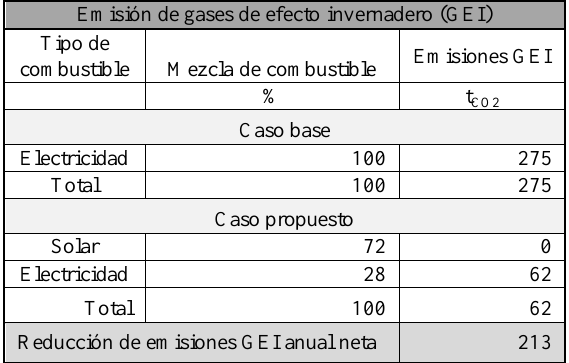
Tabla 3: Análisis de la emisión de gases de efecto invernadero.